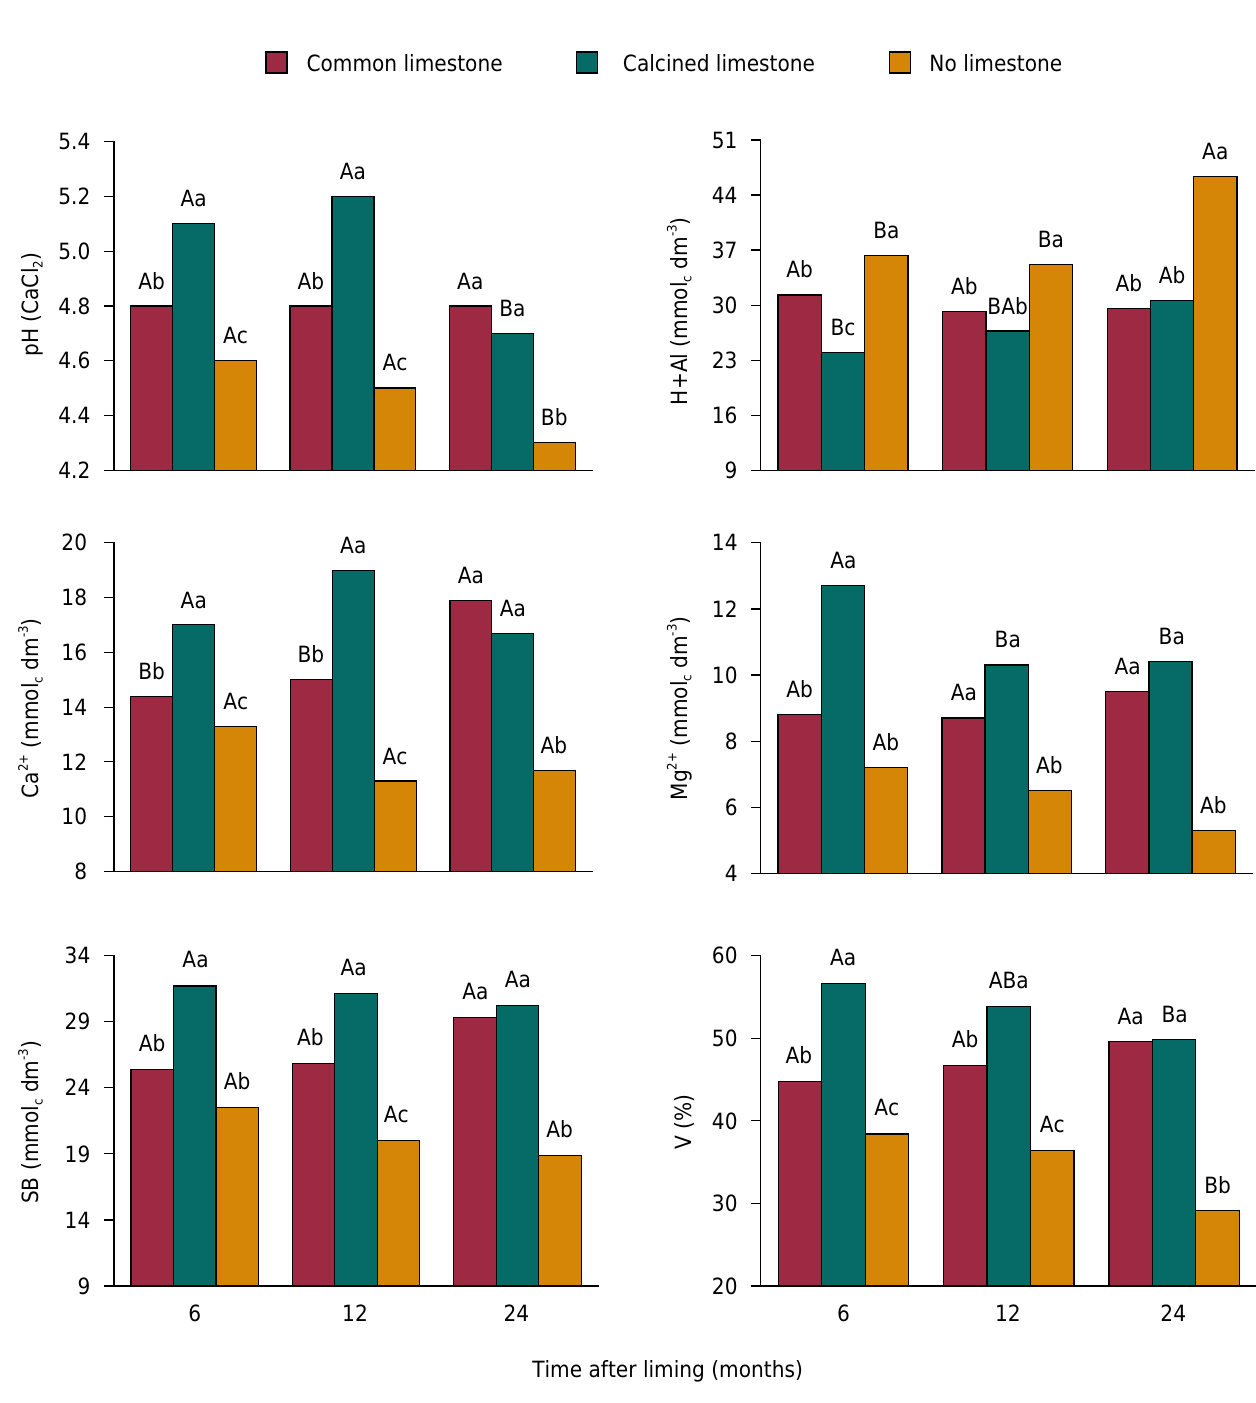
Figure 5. The values of pH, H+Al, Ca 2+ , Mg 2+ , SB, and V % in the 0.00-010 m soil layer in response to time after surface liming with common limestone, calcined limestone, and no limestone. Means followed by the same lowercase letter within the time periods (6, 12, and 24 months) and uppercase letter between the seasons for each form of limestone do not differ by Tukey’s test (p<0.05). The values represent the averages of all the application rates for each form of limestone (common lime, calcined lime) and no